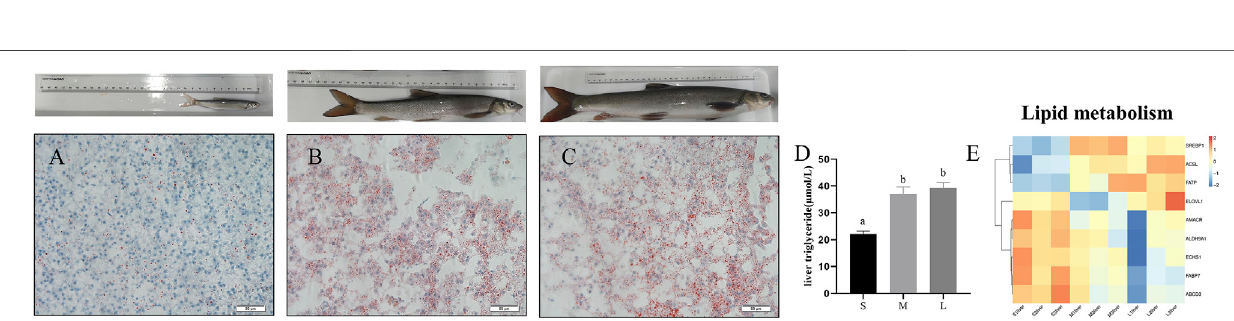
FIGURE4| OilredstainingandTGscontentinliverof S.prenanti atthreestages. (A) liveroilredOstainingofjuvenile, (B) liveroilredOstainingofyoung, (C) liveroil red Ostainingofadult, (D) thecontentoflivertriglyceride, (E) heatmapsoftheDEGsinvolvedinfattyacidbiosynthesis,fatty acidelongation,biosynthesisofunsaturated fatty acids, fatty acid degradation and PPAR signaling pathway. The juvenile, young and adult of S. prenanti denoted as S, M, and L, respectively. Data are shown as means ± SEM. Three biological replicates were used. Data are shown as means ± SEM. Three biological replicates were used. And groups denoted by different letters represent a signi fi cant difference at p <